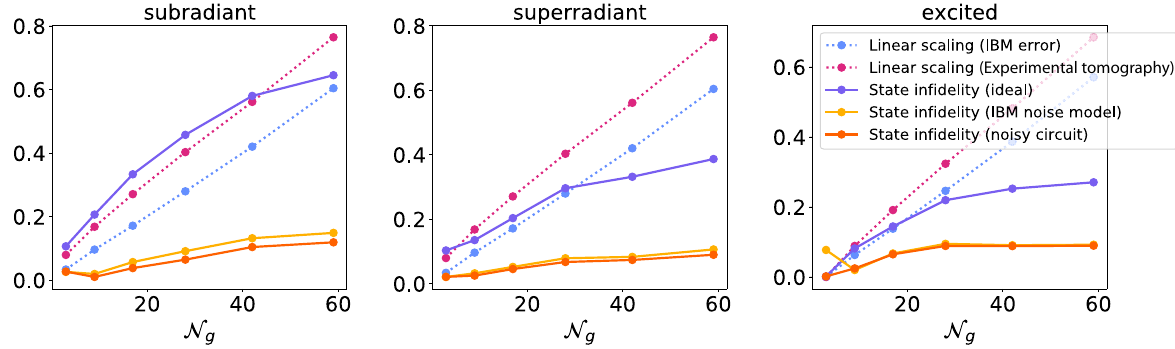
FIG. 10. The scaling of the error as a function of the number of CNOT gates in the algorithm N g during the simulation of the collective dynamics shown in Fig. 8. The markers indicate the steps of the collision model. The dotted light blue and magenta lines show the linear scaling of, respectively, the IBM gate error and the experimental average gate infidelity, given in Fig. 9. The continuous violet line shows the infidelity between the experimental state and the ideal one. The error bars for the latter quantity are obtained as the standard deviations of 100 realizations of a random sample of the state-tomography data via bootstrapping and they are within the markers. The continuous orange line shows the infidelity between the experimental state and the state simulated on the noisy circuit. The continuous yellow line shows the infidelity between the experimental state and the state simulated via the IBM noise